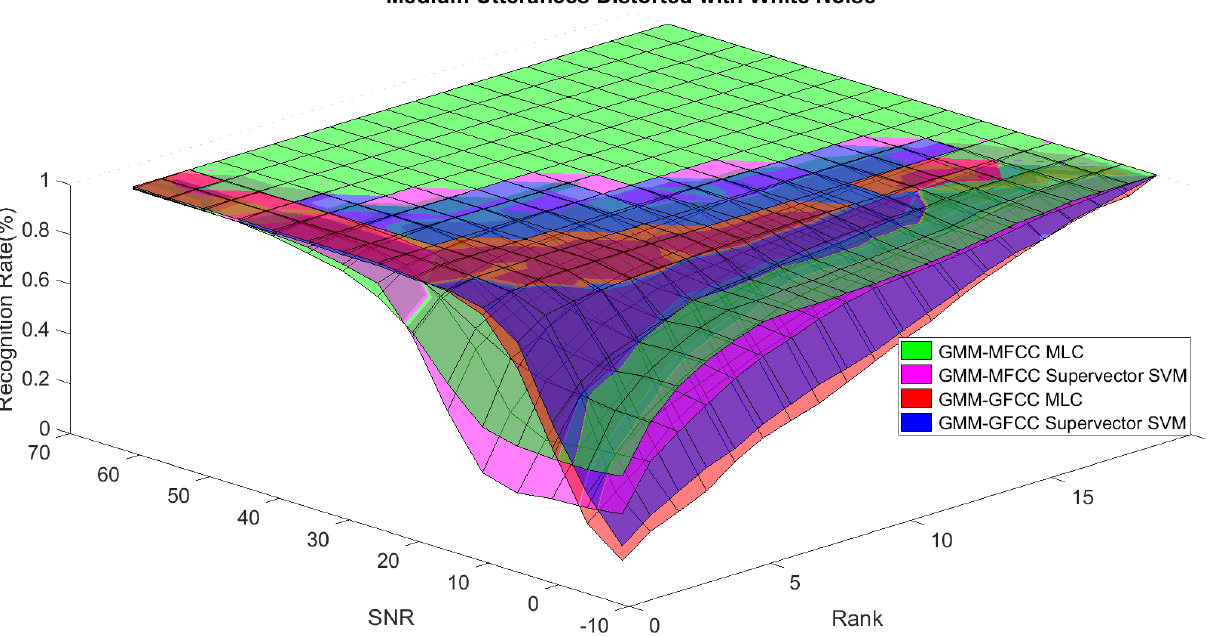
Figure 11. The 3D surface of the recognition rates for the base classifiers on medium utterances distorted with white noise.